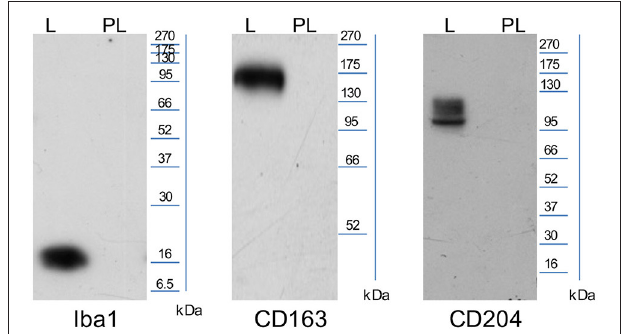
FIGURE 1 | Representative images of WB performed using SDS-page 12% (CD163 ≃ 130–180 kDA, CD204 ≃ 90–120 kDA) and SDS-page 14% (Iba1 ≃ 16 kDa; L, lymph node and PL,